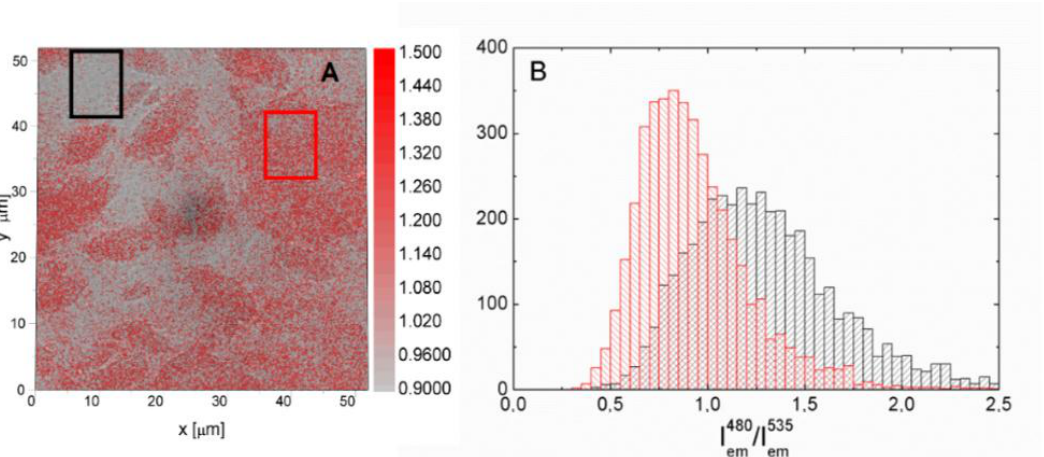
Figure 7. ( A ) Map obtained by dividing fluorescence intensity maps of PSI on rGO measured for the excitations of 480 nm and 535 nm (I em480 )/(I em535 ) superimposed over the transmission image. ( B ) Histograms of (I em480 )/(I em535 ) ratio obtained for two selected but homogenous regions of the map shown in (A).